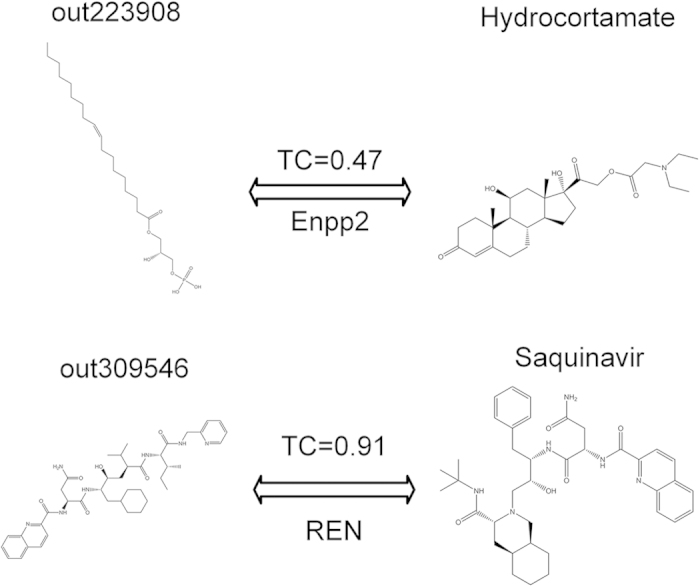
Non-intuitive (Hydrocortamate) and straightforward (Saquinavir) WES prediction, with Tc values to closest references.